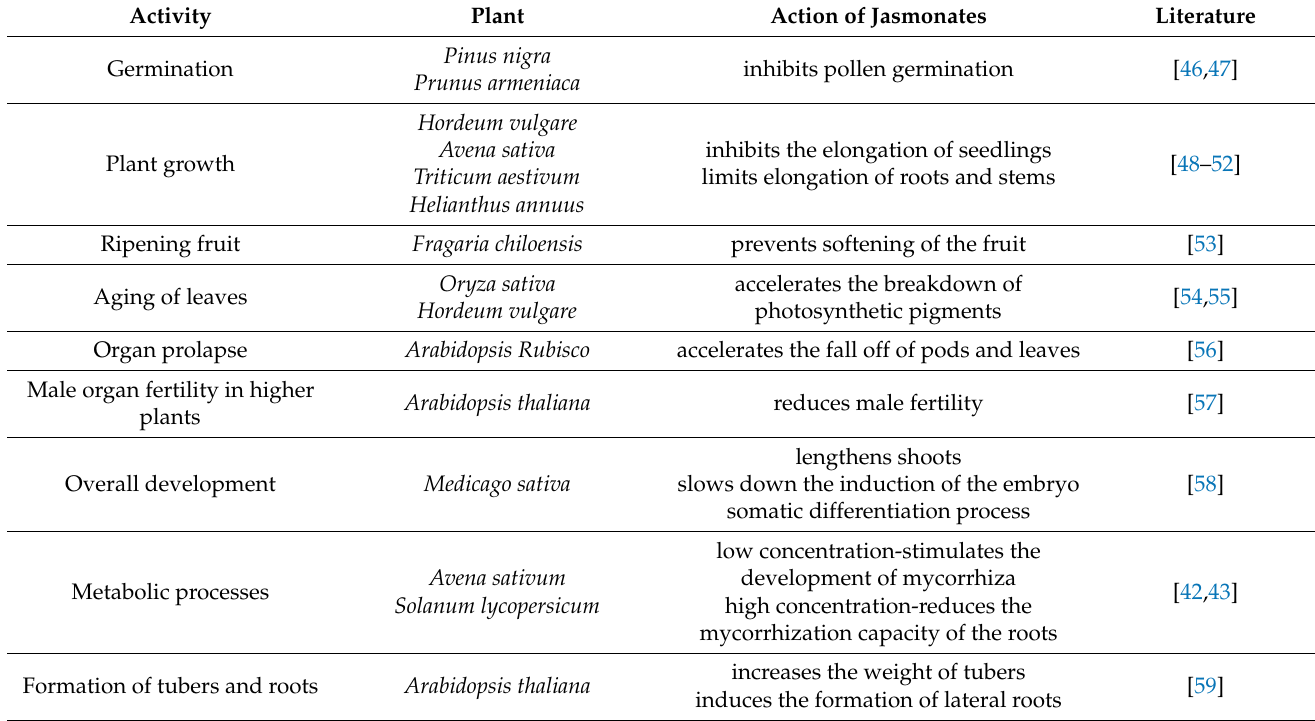
Table 1. Action of jasmonates in